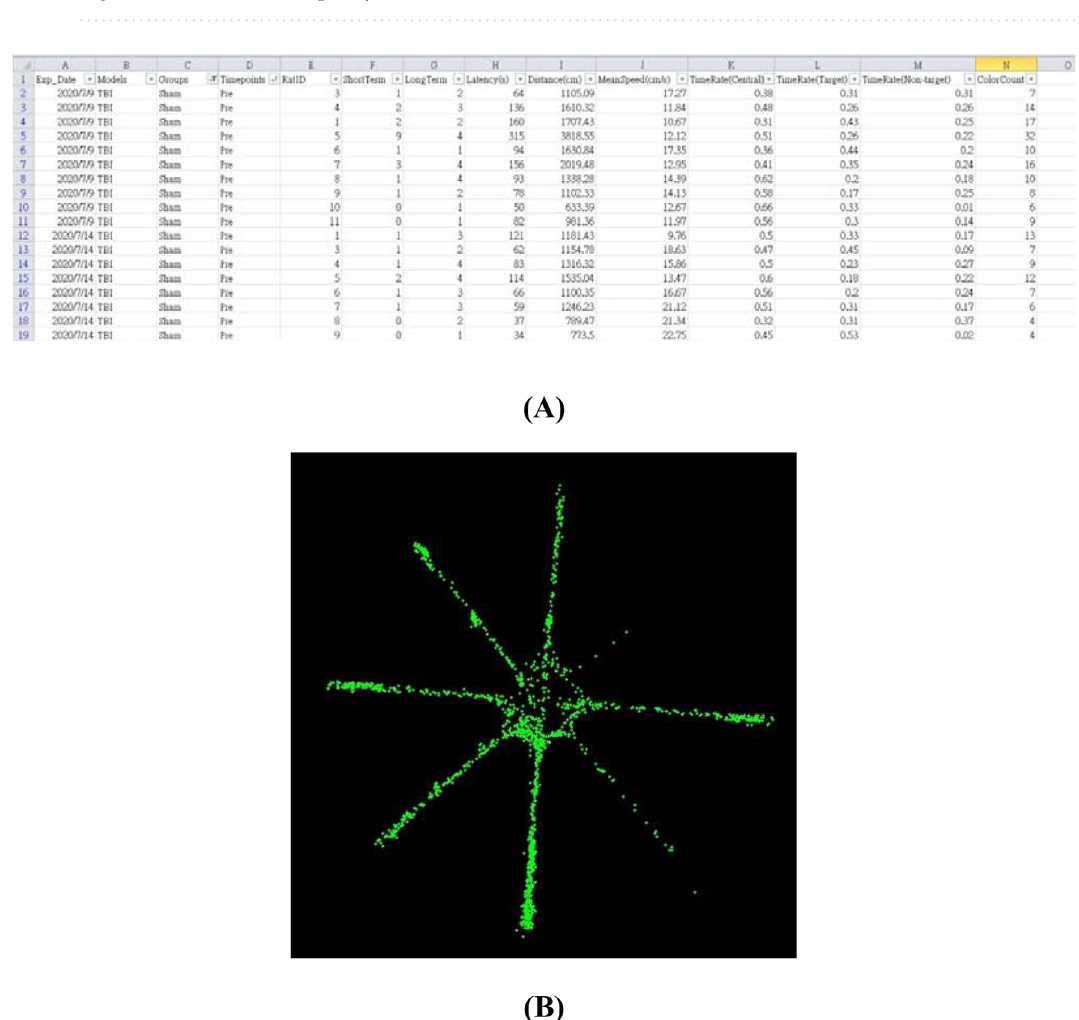
Figure 9. ( A ) cognitive quantity display and ( B ) food search trajectory